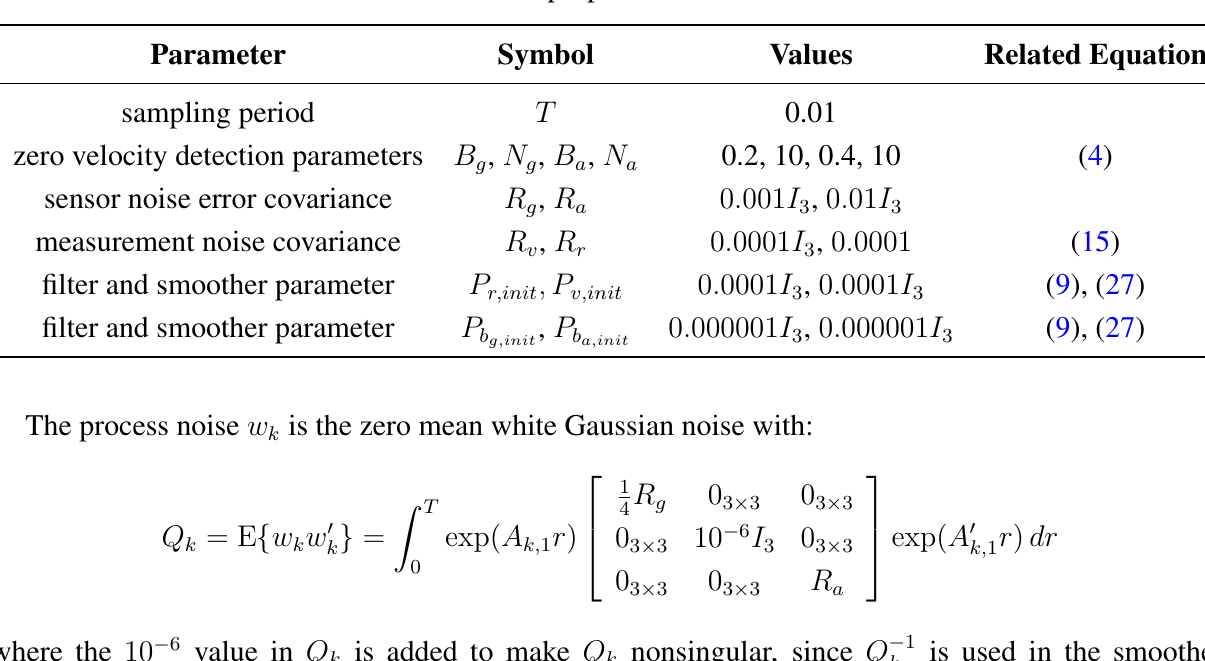
Table 1. Parameters of the proposed smoother and Kalman